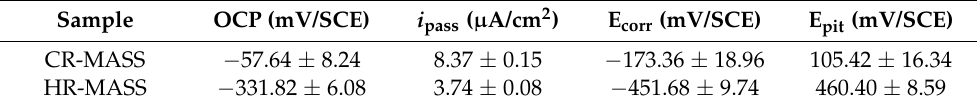
Table 2. The electrochemical parameters from OCP and PDP measurements of the experimental